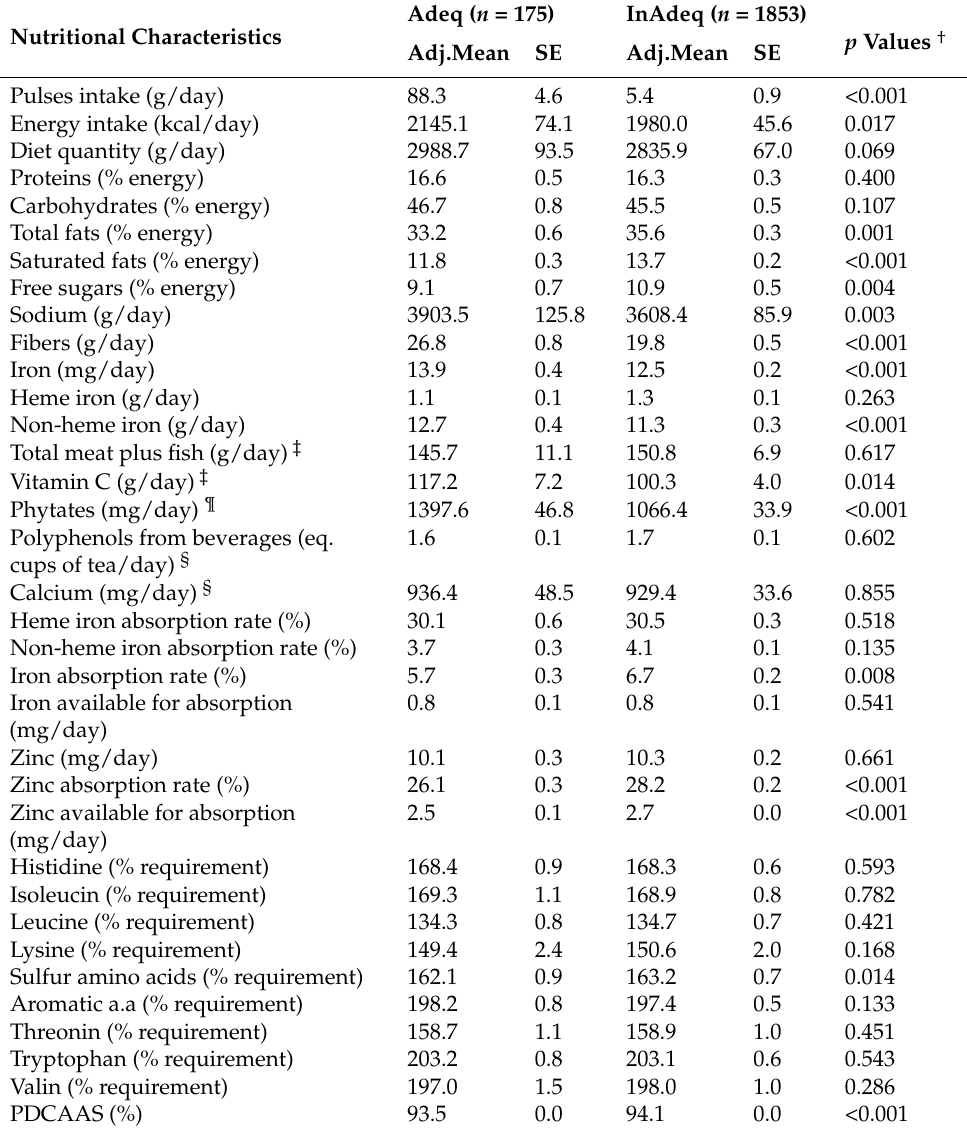
Table 3. Nutritional characteristics of observed diets fulfilling (Adeq) and not fulfilling (InAdeq) the recommended guideline for pulses (equivalent to 57 g/day). Values are adjusted * means and standard